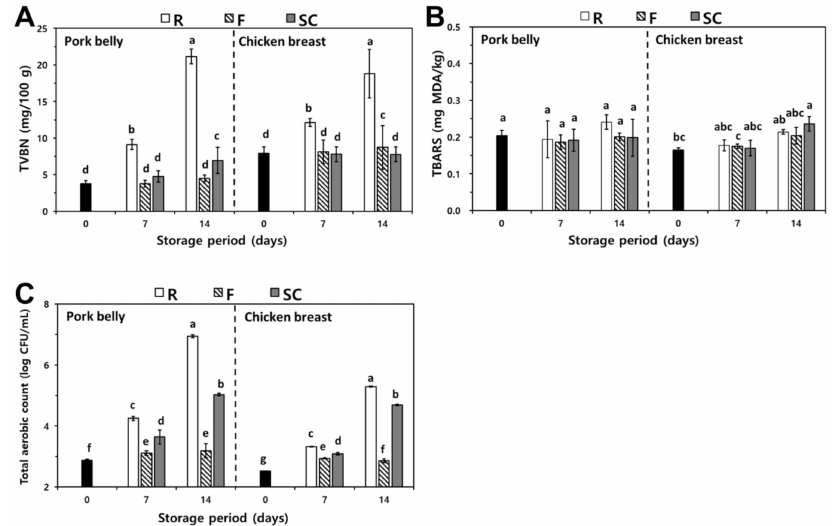
Figure 2. Changes in TVBN ( A ), TBARS ( B ), and TAC ( C ) of pork belly and chicken breast depending on various storage temperatures and periods. R, Refrigeration; F, Freezing; S. Supercooling a–e Means with different lowercase letters within the same samples are significantly different ( p < 0.05). ( n =